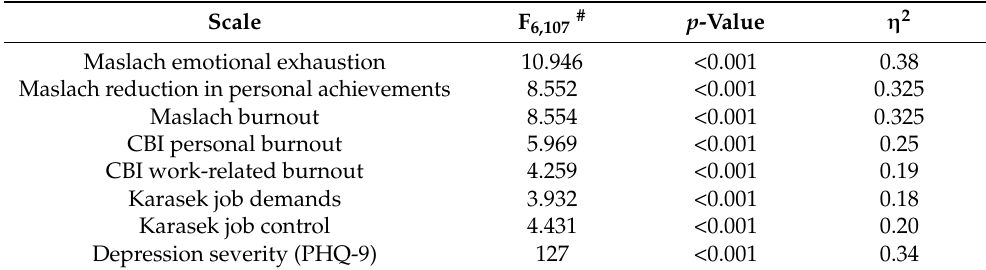
Table 4. Burnout, depression, and occupational stressors subscales comparison regarding professional groups *.